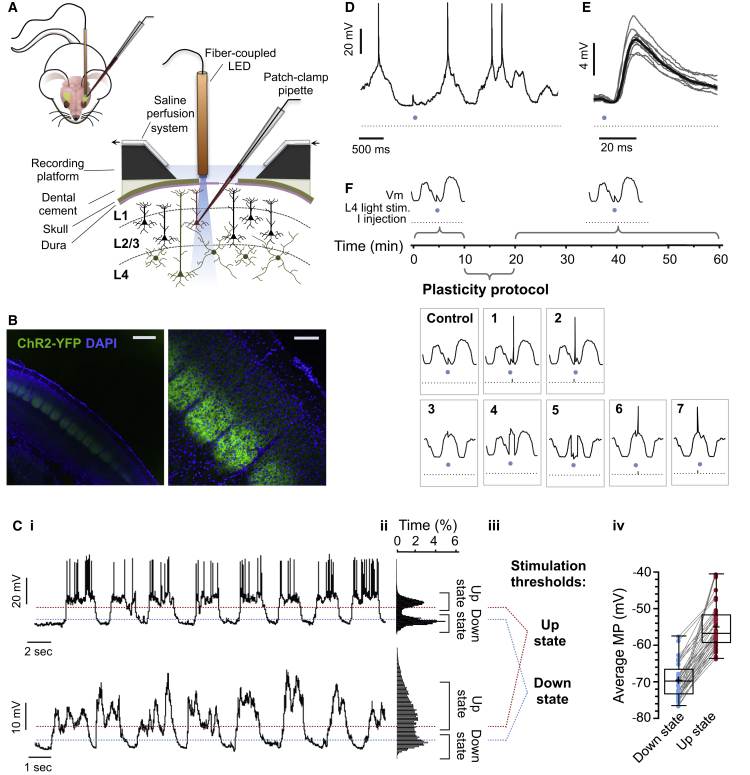
Monitoring L4 to L2/3 Synaptic Strength In Vivo(A) Schematic of the technical approach. L2/3 neurons of urethane-anesthetized Six3-cre/Ai32 mice were recorded in whole-cell mode and ChR2-expressing L4 afferent fibers were activated using a fiber-coupled LED.(B) Pattern of expression of ChR2 in the barrel cortex (scale bars: left, 500 μm; right, 200 μm).(Ci–Civ) (Ci) Example trace of highly active L2/3 neuron (top) and sparsely spiking L2/3 neuron (bottom). (Cii) Bimodal distribution of membrane potential (MP). (Ciii) Thresholds for stimulation during Up states and Down states were 0.5 mV negative to the mean Up state MP (red dotted line) and 0.5 mV positive to the mean Down state MP (blue dotted line), respectively. (Civ) Mean MP at Up states and Down states for all cells recorded (n = 92 neurons in N = 81 mice). Box-and-whisker plots represent maximum, upper quartile, mean (cross), median, lower quartile, and minimum values.(D) Example trace of light-evoked EPSP during Down state. A closed-loop was used to elicit EPSPs only at MP negative to Down state threshold. Spikes are truncated for clarity. See also Figures S1 and S2.(E) Ten overlaid traces of light-evoked EPSPs during Down states (gray) and their mean (black).(F) Diagram of the experimental design. EPSPs were monitored for 10 min using a 2-ms light pulse only during Down states (<0.1 Hz). Subsequently, one of eight protocols was applied (100 repetitions at <0.2 Hz): light stimulation at Down states only (control); light-stimulation at Down states followed (1) or preceded (2) by postsynaptic spike; light pulse during Up states only (3); light pulse during Down states paired with postsynaptic depolarization (4); light pulse during Up states paired with postsynaptic hyperpolarization (5); and presynaptic light stimulation during Up states followed (6) or preceded (7) by a postsynaptic spike. Following the plasticity protocol, EPSP was monitored by light stimulation during Down states (<0.1 Hz) for 20 to 30 min.